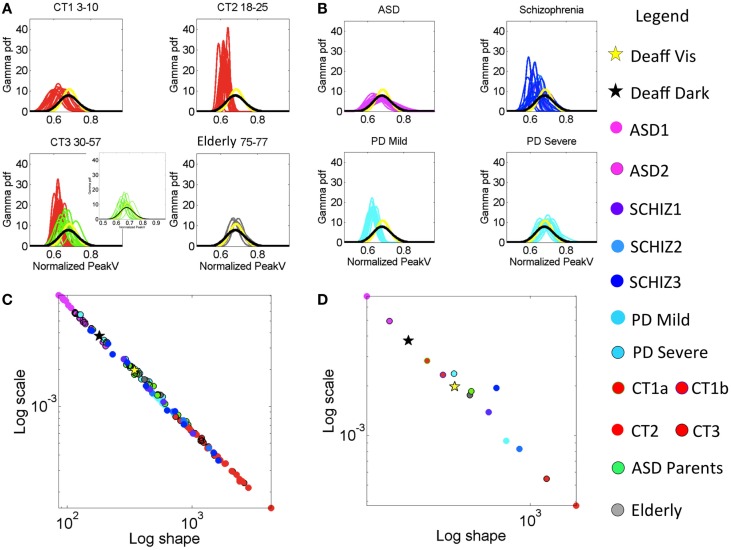
Characterization of the stochastic signatures of the normalized peak velocity index estimated from fluctuations in this parameter across individualized task performance as well as for the group patients under consideration. (A) Estimated PDFs for control groups. Top-left panel is the group of typically developing (control) children CT1 between 3 and 10 years old. Top-right panel CT2 contains the young participants (18–15 years old). Bottom-left panel CT3 is from 30- to 57-year-old participants. This panel also contains PDFs estimated from the parents of ASD children (green traces). Bottom-right panel is elderly participants between 75 and 77 years old. (B) Estimated PDFs from neuropsychiatric and neurological disorders: top-left is ASD (3–25 years old). Top-right is SZ (22–57 years old, see Table S1 in Supplementary Material for age break down). Bottom-left is mild PD and bottom-right is severe PD. All PDFs are plotted against those of the deafferented subject (yellow trace is from the condition with visual feedback and black trace from the dark condition.) (C) Power law relation (see text for fit exponent value and goodness of fit) on the log–log Gamma parameter plane between the estimated shape and the estimated scale parameters of the continuous Gamma family of PDFs. Each dot corresponds to an individual participant. (D) Notice the mean values taken across participants in each group whereby the ASD group falls apart with the highest noise and the value of the shape parameter tending away from the Gaussian distribution case.